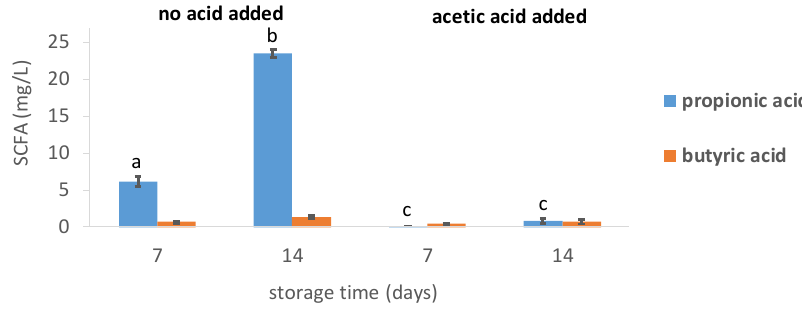
Figure 5. Impact of acetic acid addition for 8 °C storage in open tubes—storage experiment 1. Lowercase letters (a, b, c) denote significant differences. Propionic acid values that are not labelled by the same letter are significantly different. Because there was no significant interaction between the effect of preservation time and acetic acid addition on butyric acid levels ( p = 0.17), no post-hoc analysis was performed, and no letter labels were added for butyric acid in the figure.